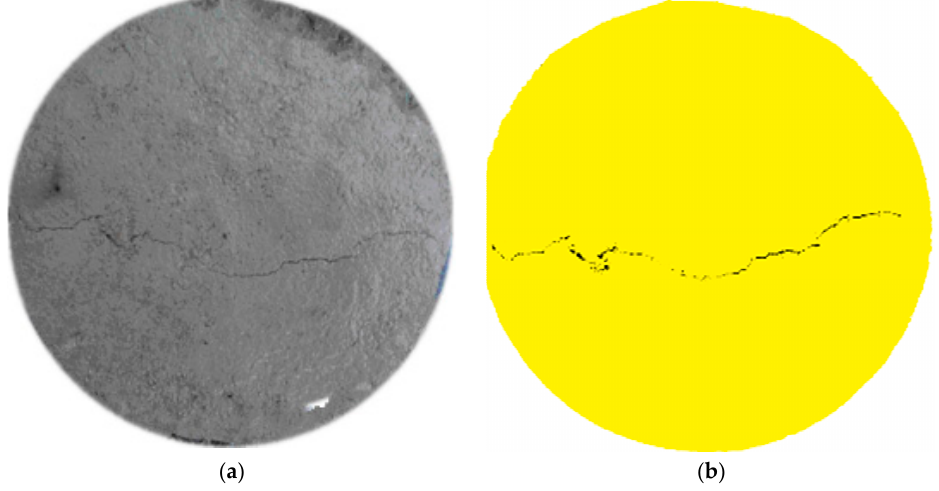
Figure 6. Distinguishing cracks using digital images. ( a ) Grey image of cracked specimens; ( b ) Crack distribution on the concrete.